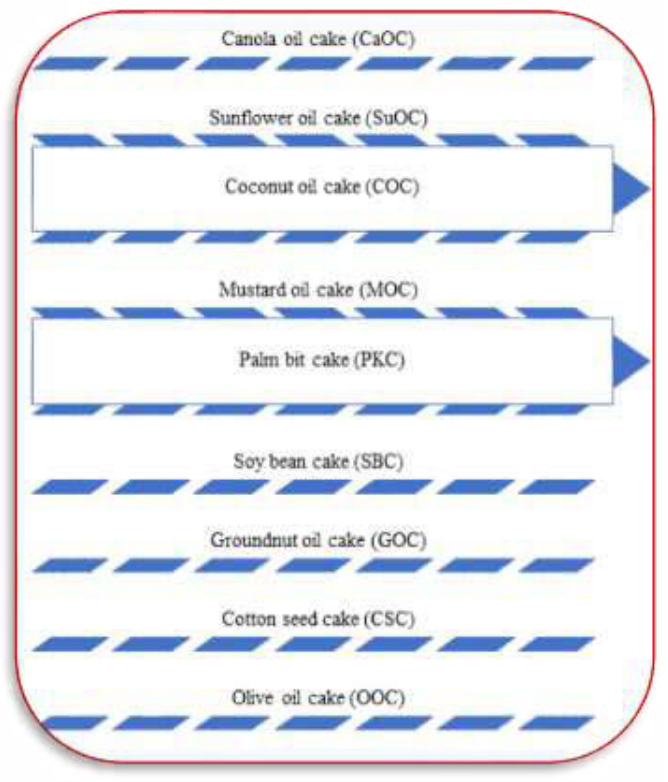
Fig. 2: Different types of oil cakes from the agriculture sectors